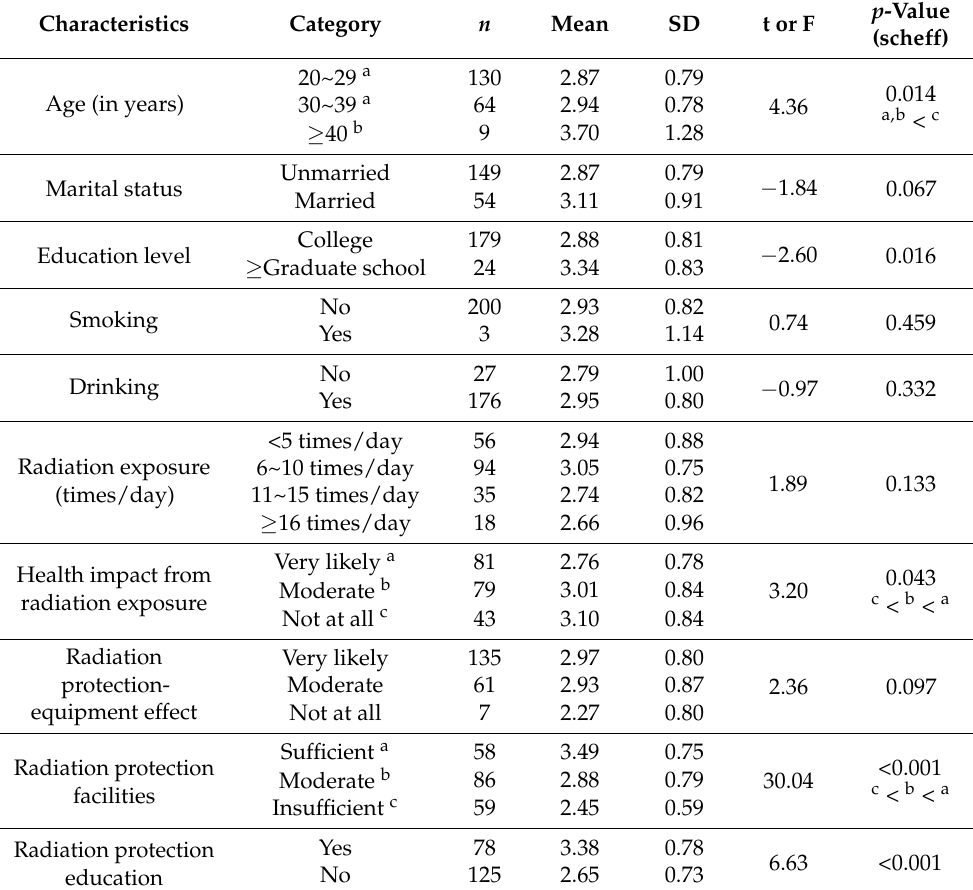
Table 1. Differences in PBDRE according to general characteristics by t -test or one-way ANOVA.